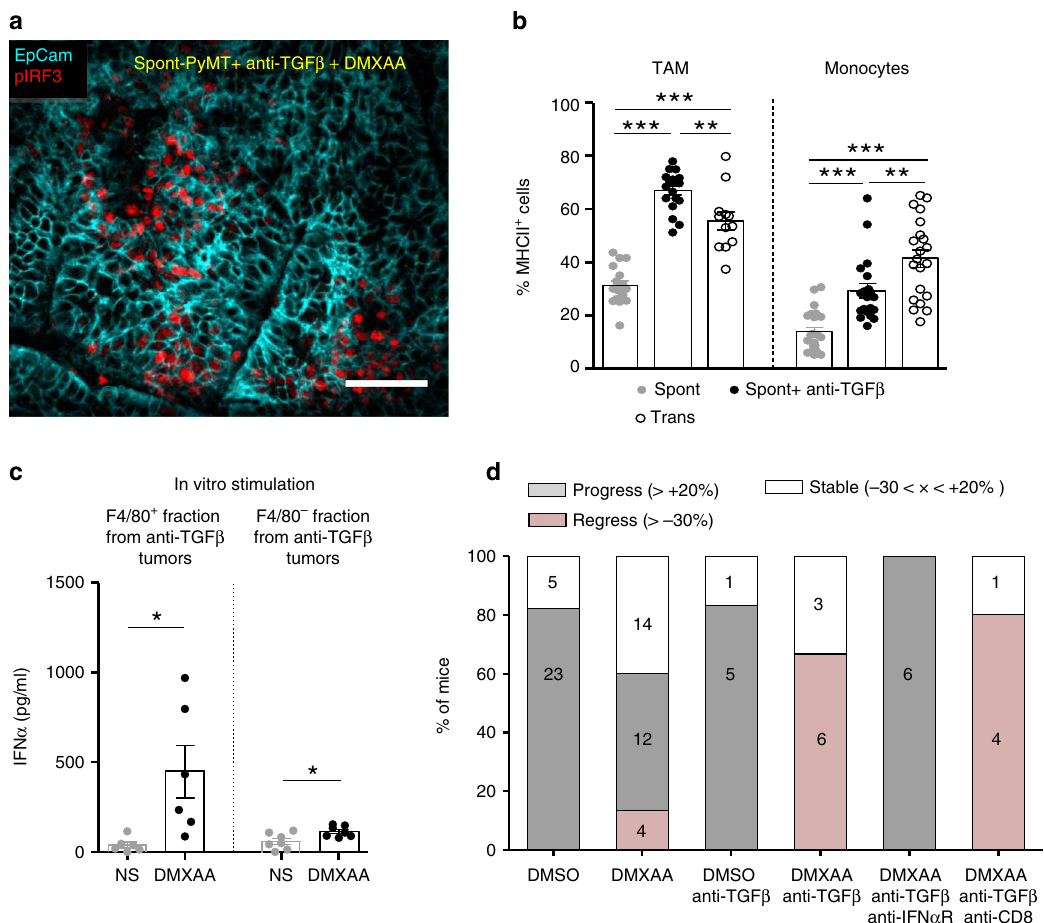
Fig. 6 Blocking TGF β allows DMXAA-induced type I IFN production and tumor regression. a Spont-PyMT mice, treated with an anti-TGF β (day − 4